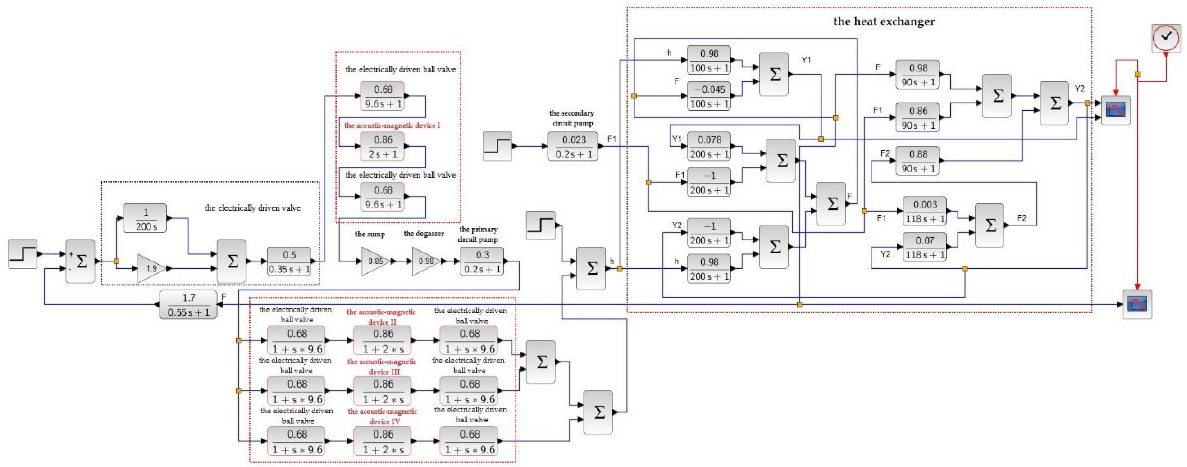
Figure 8. Scheme for studying the temporal characteristics of the automatic control system model for the heat carrier temperature of the heat exchanger of a heat supply system with acoustic–magnetic devices in the simulation environment Scilab 6.1.